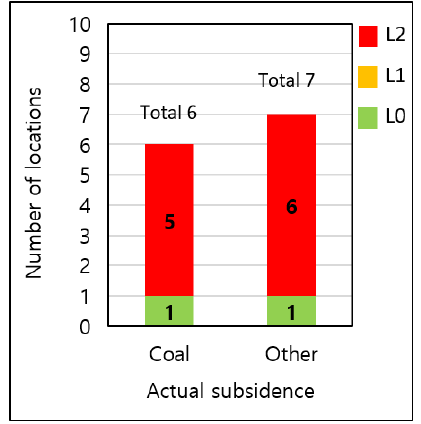
Figure 19. Subsidence risk grade for the new